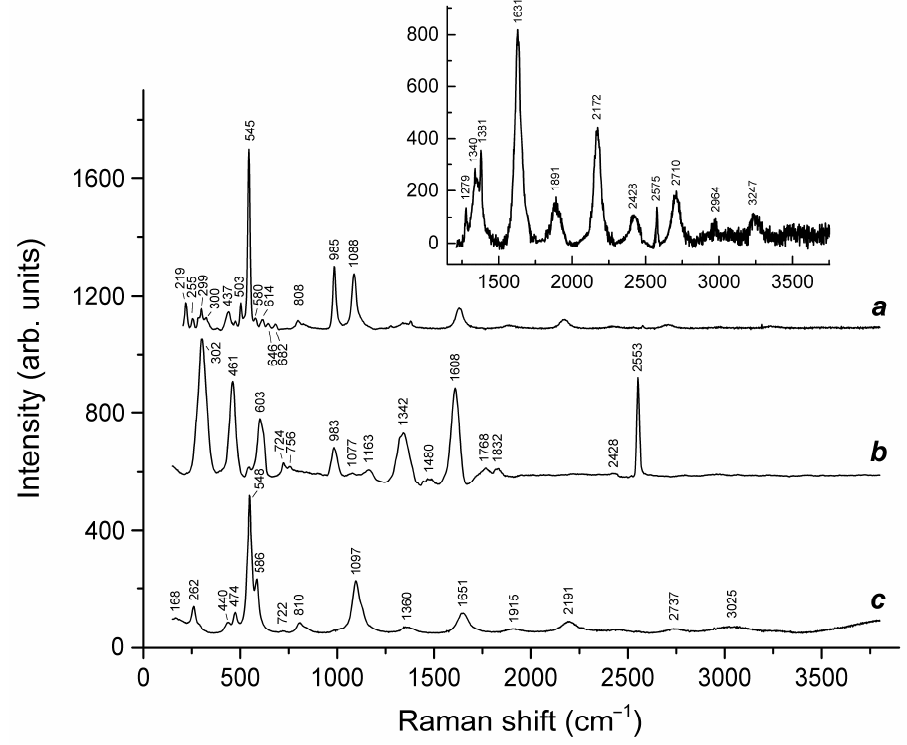
Figure 20. Raman spectra of ( a ) initial slyudyankaite (Sample 6), ( b ) Sample 6 preheated for three days at 700 ◦ C, over the Fe-FeS buffer, and ( c ) preheated Sample 6 additionally annealed at 800 ◦ C in air for one day. The inset shows the Raman spectrum of initial Sample 6 in the range of 1200–3750 cm −1 . Table 5. Assignment of Raman bands of slyudyankaite and products of its thermal conversions.